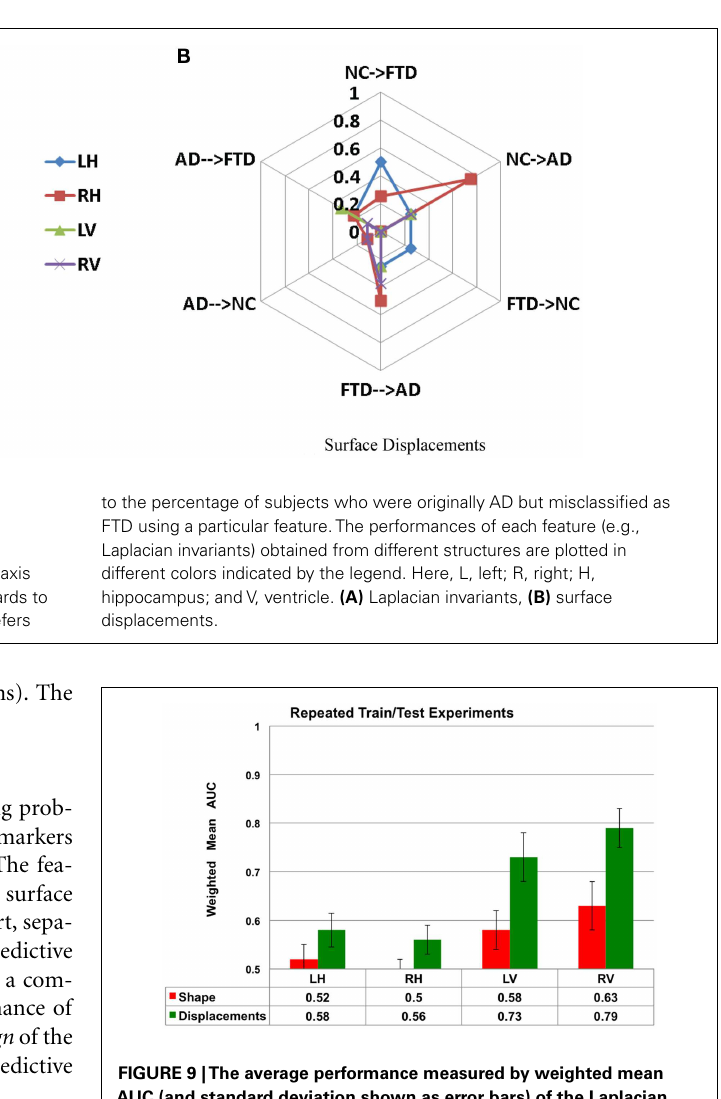
FIGURE 9 |The average performance measured by weighted mean AUC (and standard deviation shown as error bars) of the Laplacian invariant and displacement features from 10 repetitions of the train/test experiment . In each repetition, new training (75%) and test sets are randomly generated and the experiment as described in the Section “Multi-Class Classification” is repeated.The average weighted mean AUC and the standard deviation are computed and compared in this plot.These results demonstrate the robustness of the performance of the displacement features to varying training and test sets.The performance of volume features is not shown to increase